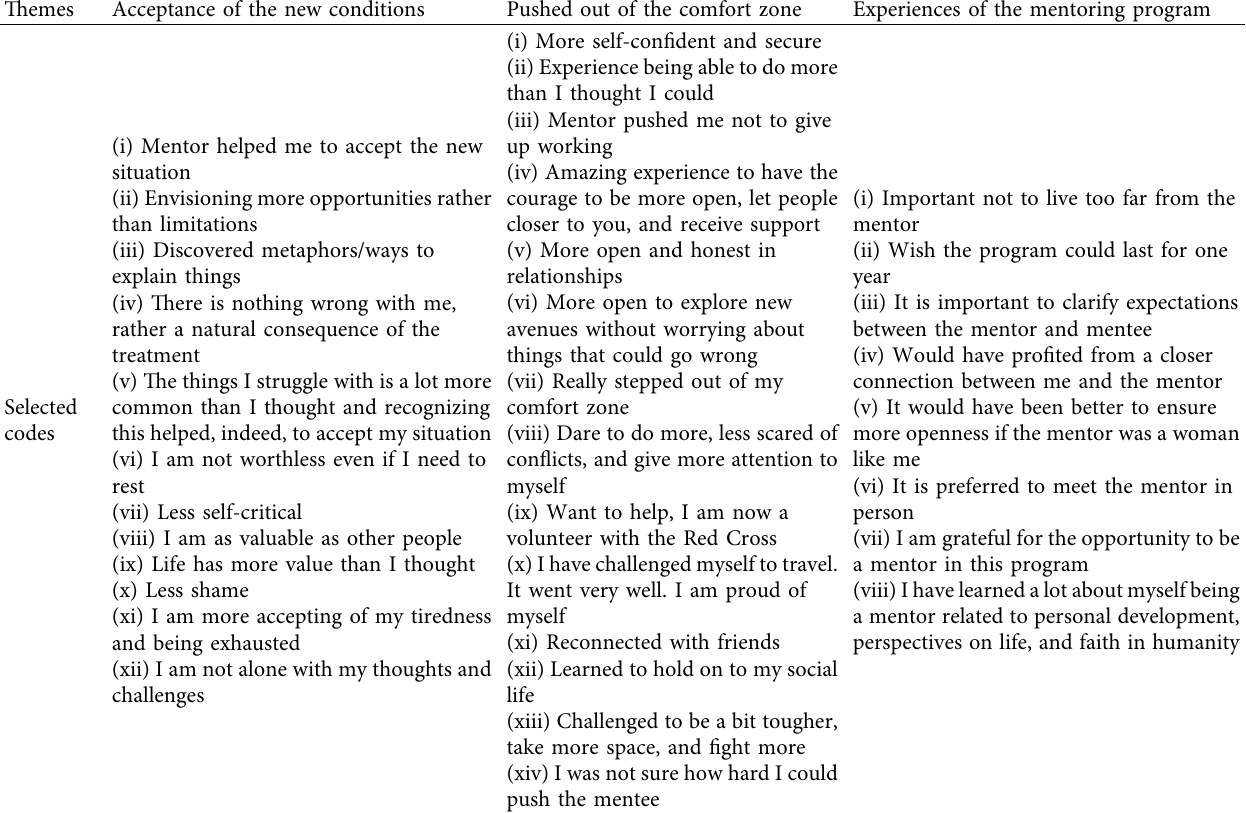
Table 3: Codes and themes extracted from the participants’